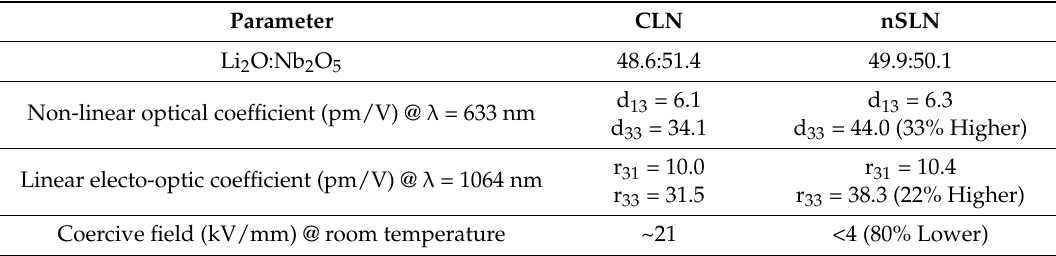
Table 1. A few properties of congruent lithium niobate (CLN) and near-stoichiometric lithium niobate (nSLN) crystals [9,10].